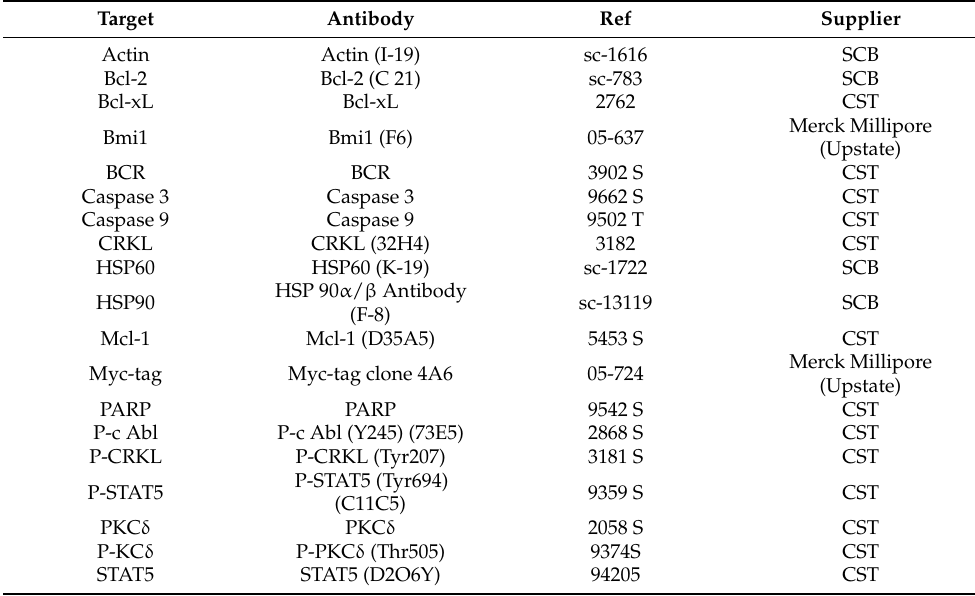
Table 3. Antibodies used in Western blotting